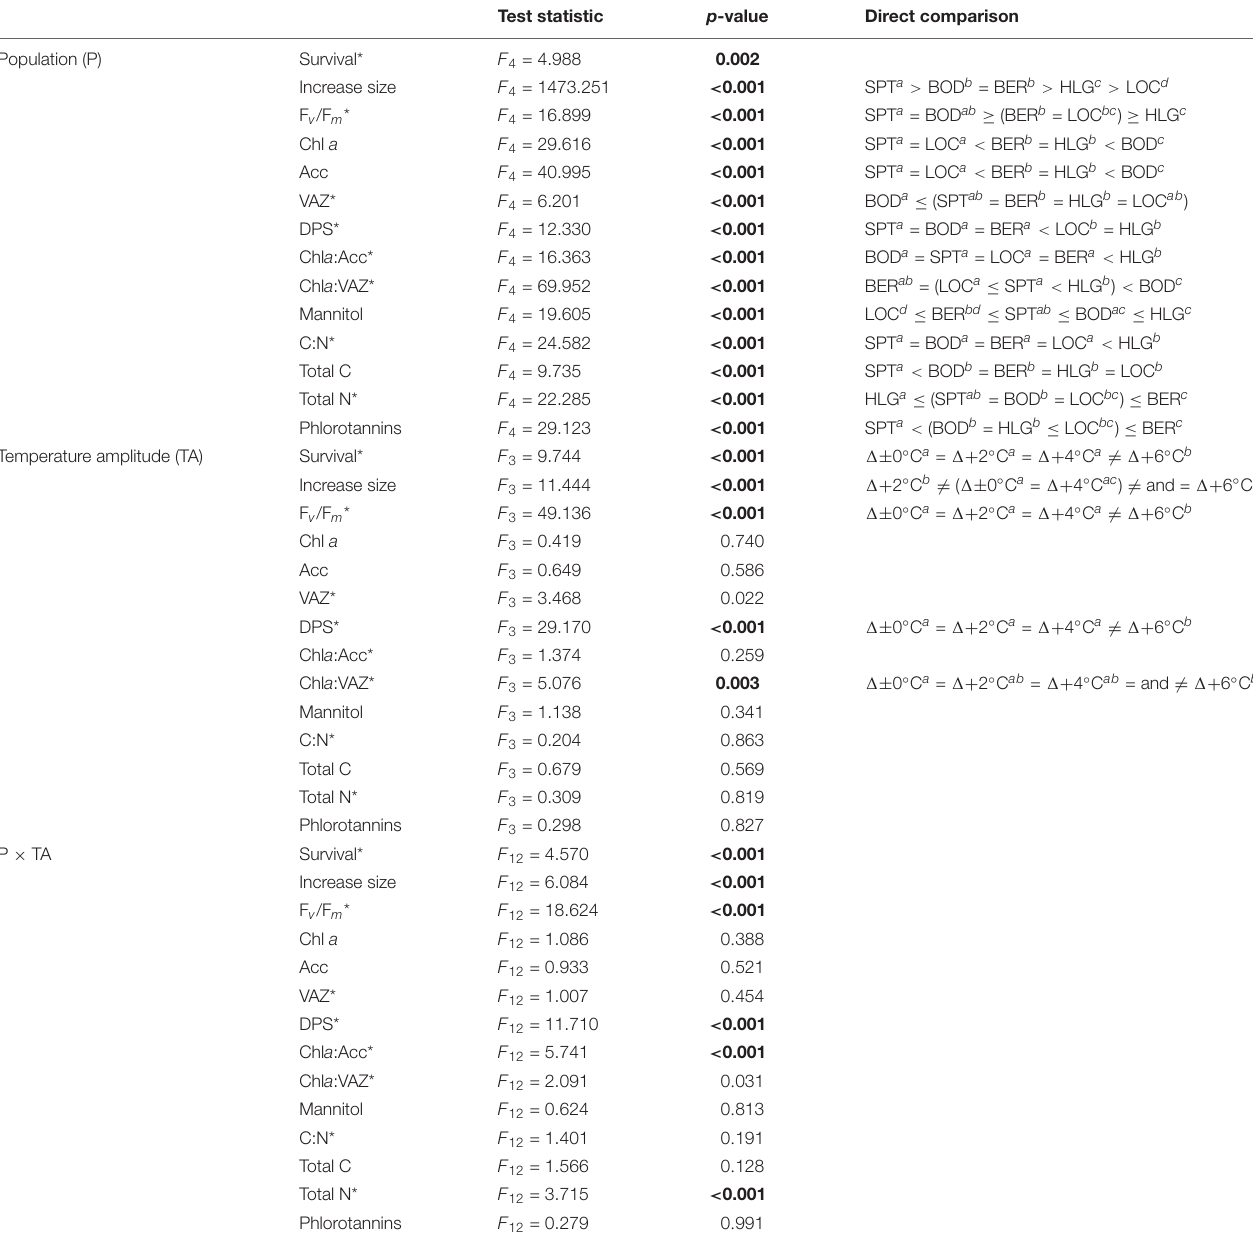
TABLE 4 | Summary of results of statistical analyses determined between the populations [P: Spitsbergen (SPT), Bodø (BOD), Bergen (BER), Helgoland (HLG), Locmariaquer (LOC)] and temperature-amplitude treatments (TA: (cid:49) ± 0 ◦ C, (cid:49) + 2 ◦ C, (cid:49) + 4 ◦ C, (cid:49) + 6 ◦ C), and their interaction (P × TA) for the measured physiological and biochemical